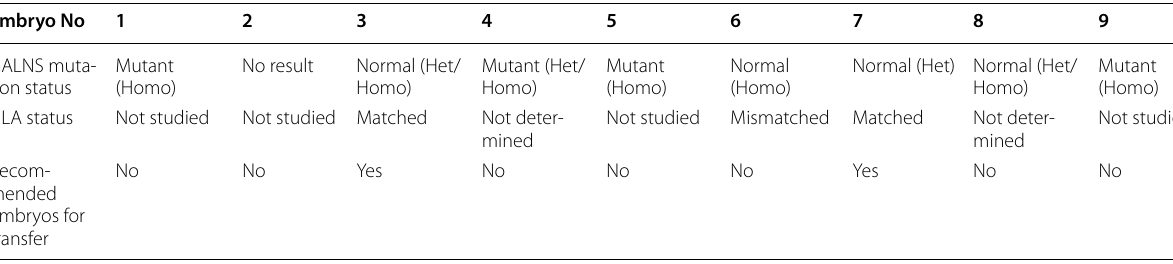
Table 3 The summary of the PGD testing results for MPS IVA and HLA typing Embryo